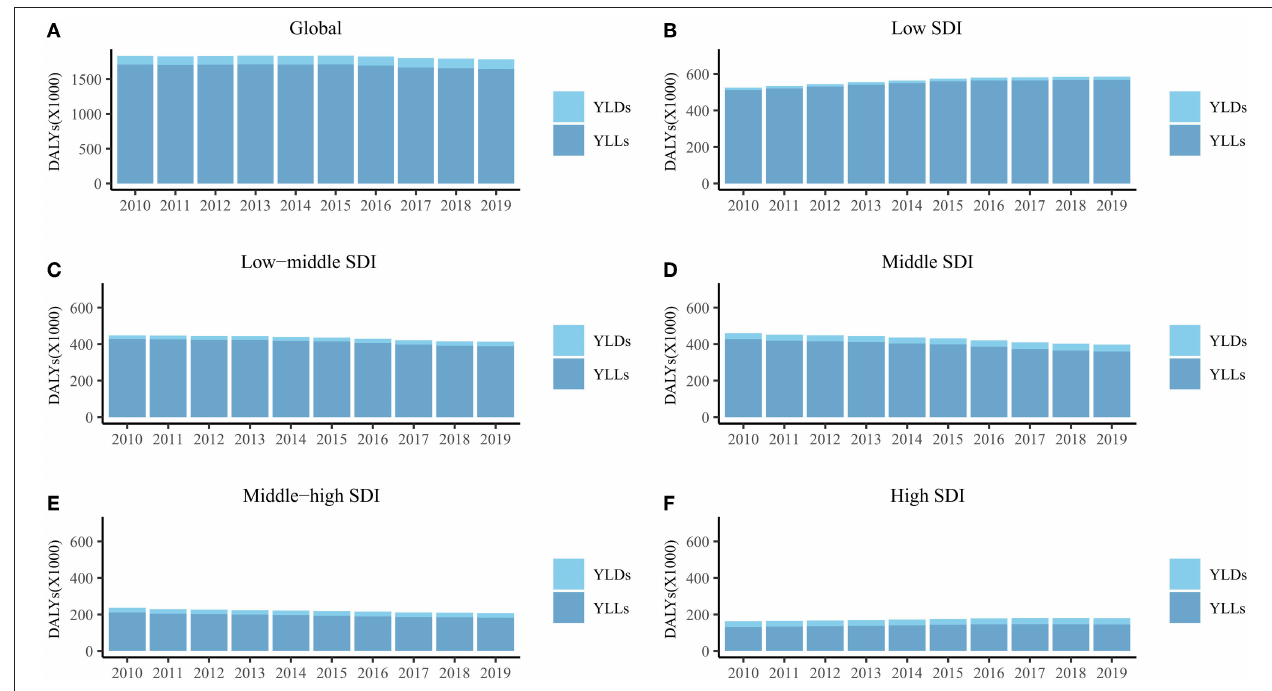
FIGURE 1 | The DALYs, YLDs, and YLLs of Down syndrome for global (A) , low SDI region (B) , low-middle SDI region (C) , middle SDI region (D) , middle-high SDI region (E) and high SDI region (F) from 2010 to 2019. DALYs, disability-adjusted life years; YLDs, years lived with disability; YLLs, years of life lost; SDI, socio-demographic index.